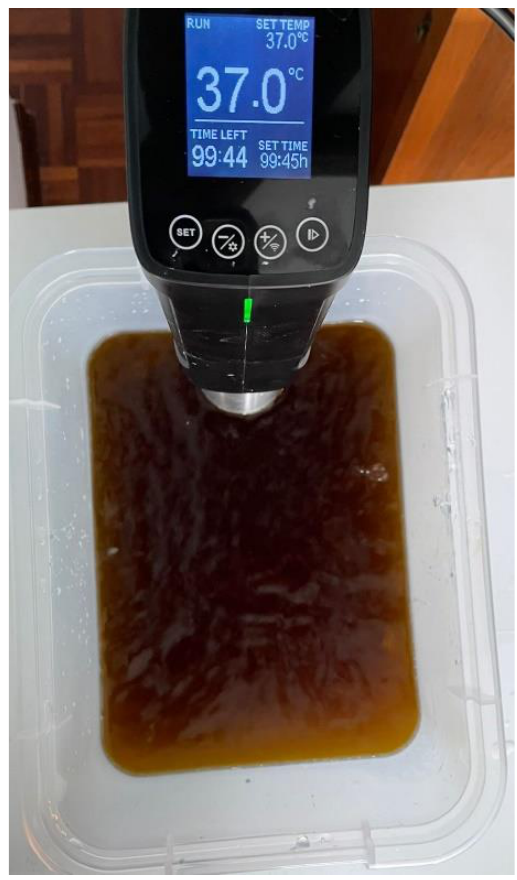
Figure 2. Saliva bath used to age the samples.